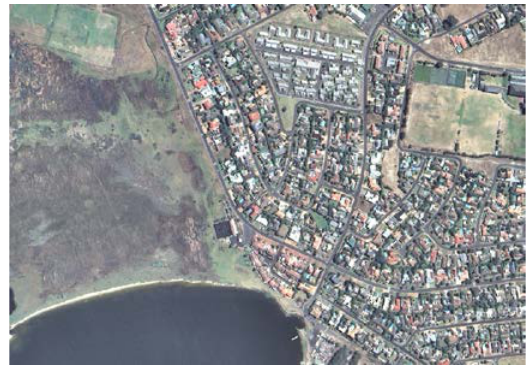
Figure 1: Subset of aerial image used in all classification methods tested